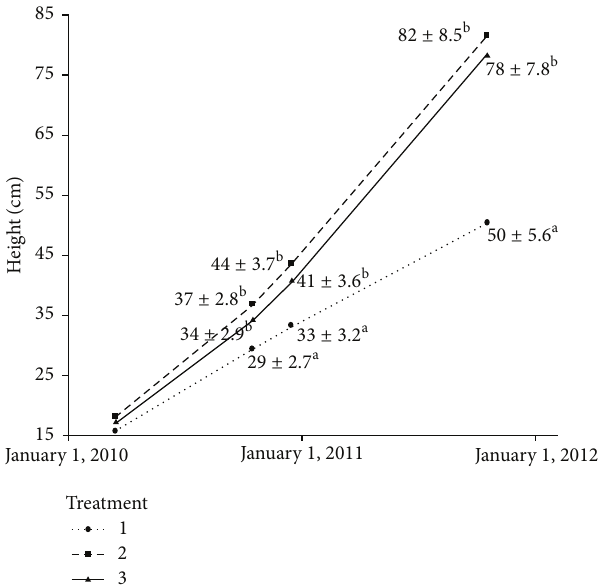
Figure 3: Mean basal diameters at planting date (March 2010) and after 7 months (October 2010) and 9 months (December 2010). Treatment 1: control. Treatment 2: seedlings with 120cm shelters. Treatment 3: seedlings with 150cm shelters.